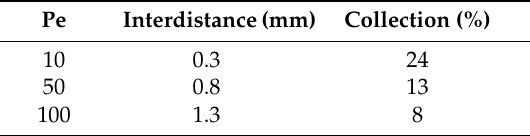
Table 3. Trail effect. Dimensional parameters obtained from the second electrode collection